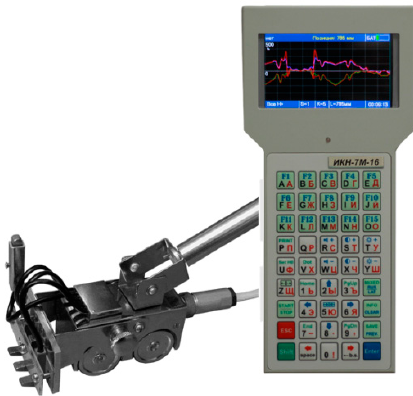
Figure 4. Experimental setup.